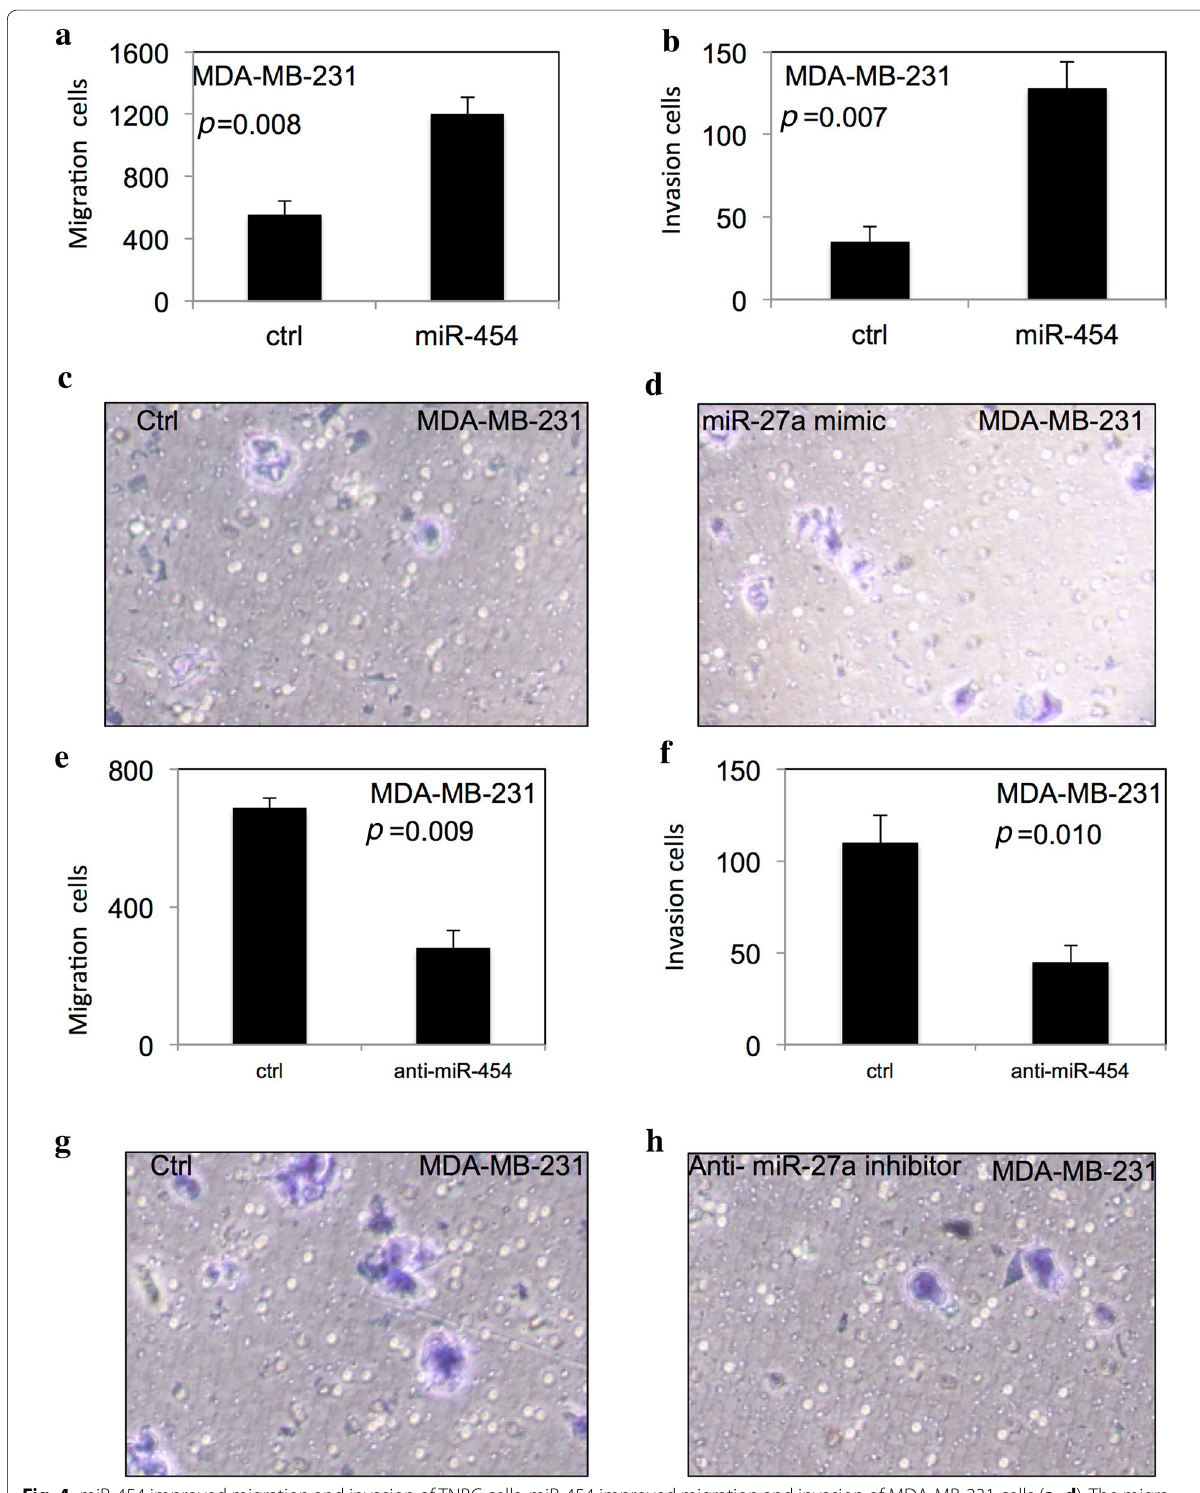
Fig. 4 miR-454 improved migration and invasion of TNBC cells. miR-454 improved migration and invasion of MDA-MB-231 cells ( a – d ). The migra- tion and invasion of MDA-MB-231 cells were decreased after downregulation of miR-454 ( e – h ). The migration and invasion of MDA-MB-468 cells were decreased after downregulation of miR-454 ( e – h ). All experiments were performed in